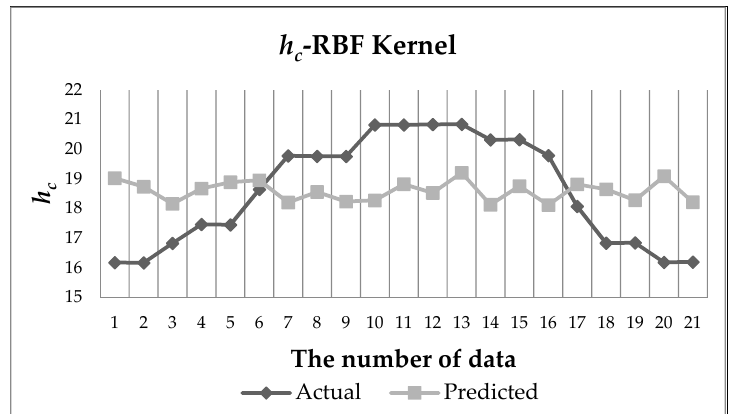
Figure 10. Actual and Predicted data of h c for Pearson VII (PUK) kernel.